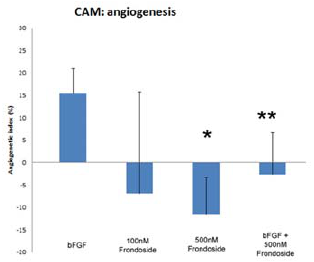
Figure 6. Quantification of CAM angiogenesis assay: Bars indicate angiogenic indices (%) of CAM’s probed with 2 m g/mL bFGF, 100 nM Frondoside A, 500 nM Frondoside A, 2 m g/mL bFGF + 500 nM Frondoside A. Data represents mean 6 SD (Mann-Whitney U-test, *: p , 0.05, ***: p , 0.01). In each experiment, six eggs were tested per condition.